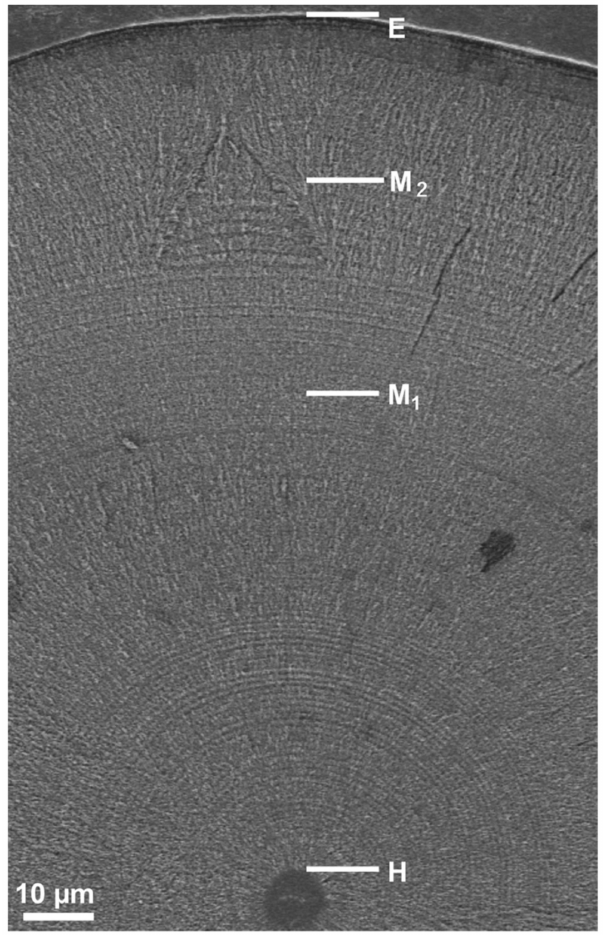
Figure 2. A SEM image shows the otolith microstructure of a A. marmorata glass eel collected on the beach on Tanegashima Island, Japan. H, hatch check; M 1 , initiation of metamorphosis; M 2 , completion of metamorphosis; E, otolith edge.